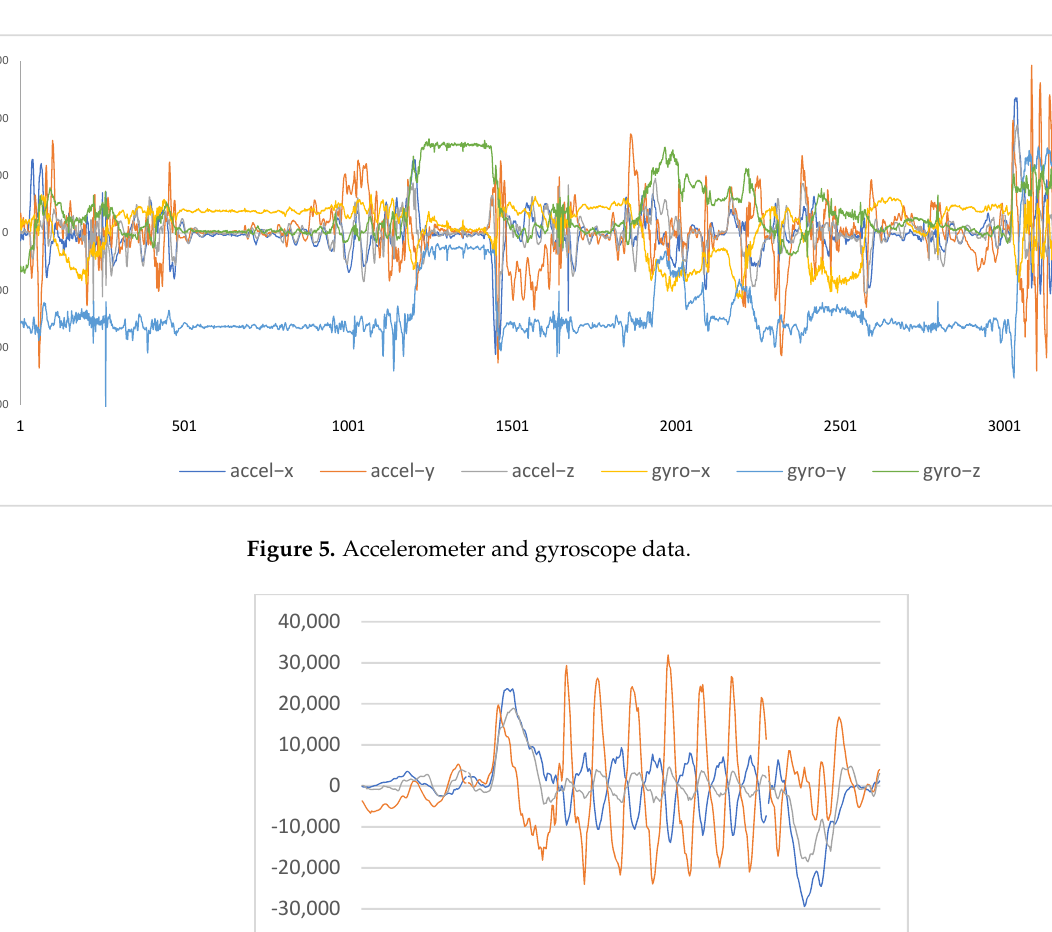
Figure 6 . Eye rubbing accelerometer data .